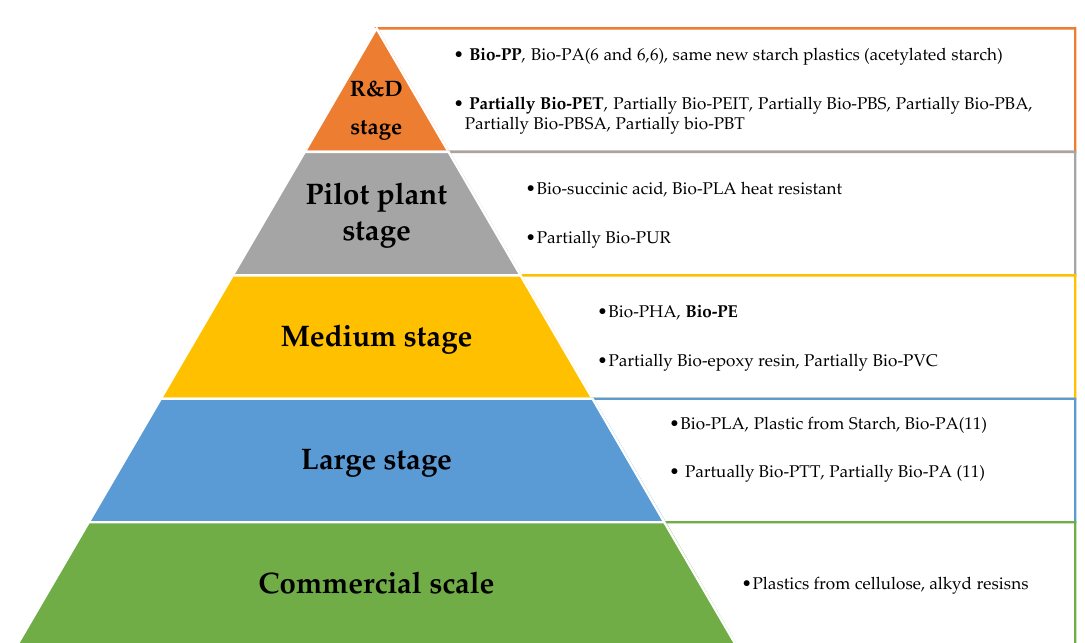
Figure 11. Development stages for emerging bio-based polymers.